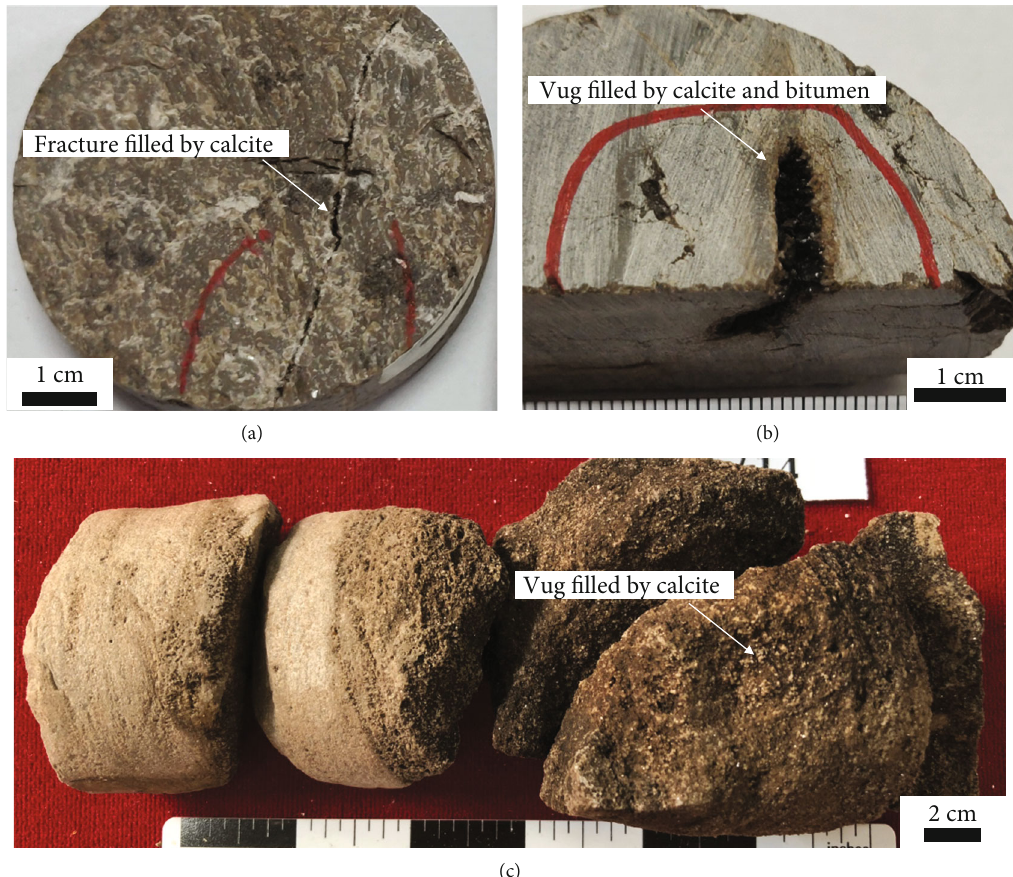
Figure 2: Core photos showing various petrography. (a) Core photo (SHB5-8; 7678.5 – 7678.7m; O (b) Core photo (SN5-1x; 7481.4 – 7481.6; O yj ) showing the vug fi lled by calcite and bitumen. (c) Core photo (SHBp1; 8450.6 – 8450.8 m; O 2 showing the porous O y 1 − 2